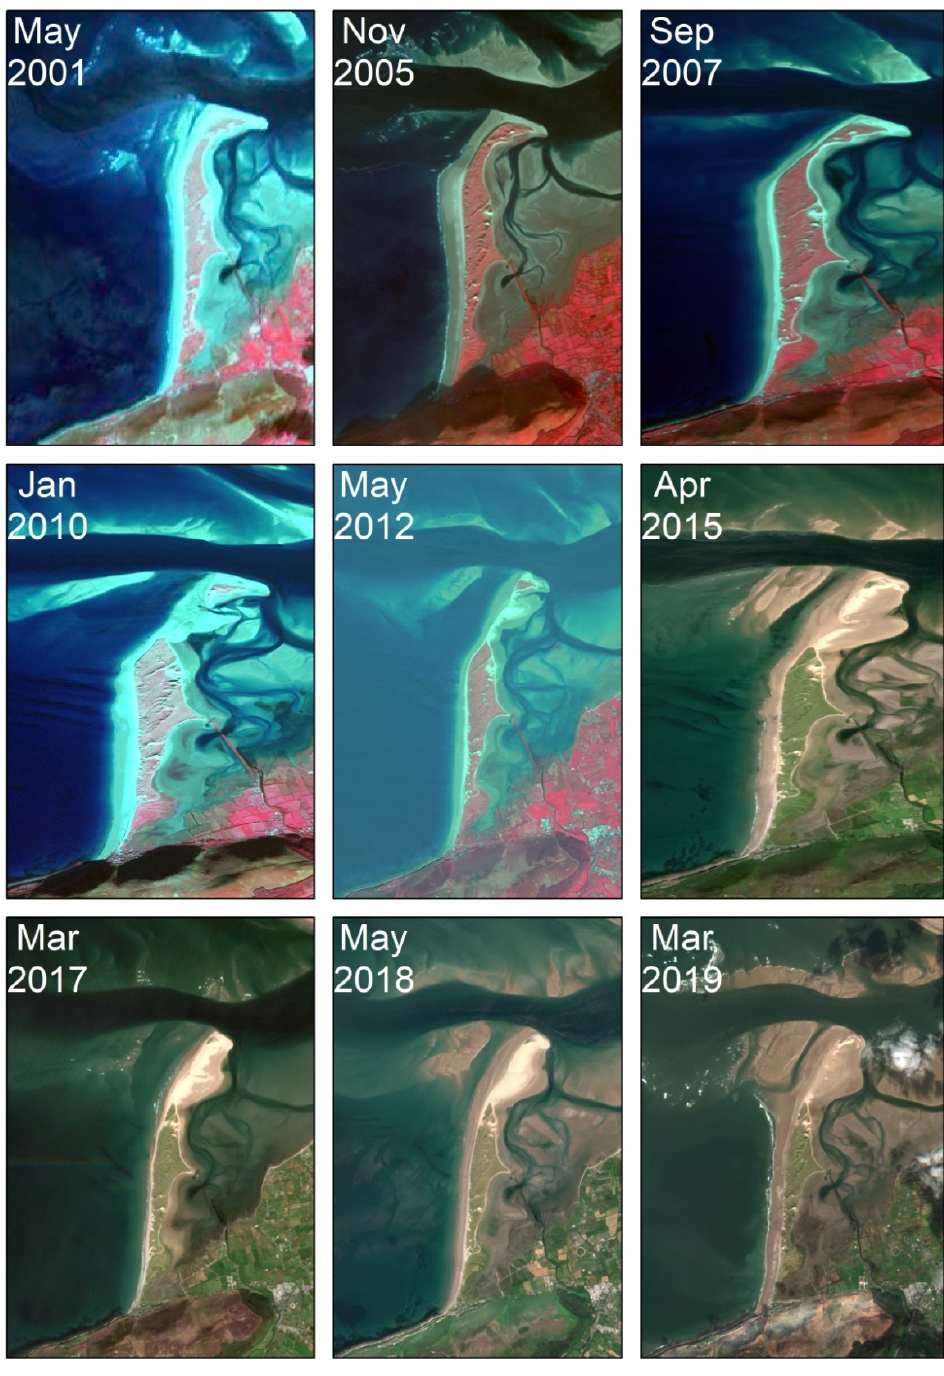
Figure 2. Barrier Figure 2. Barrier alignment.